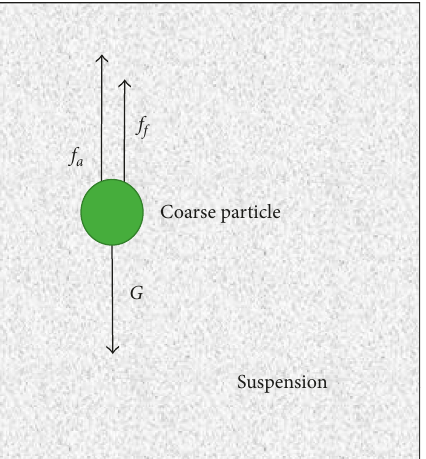
Figure 1: Analysis of forces received by the coarse